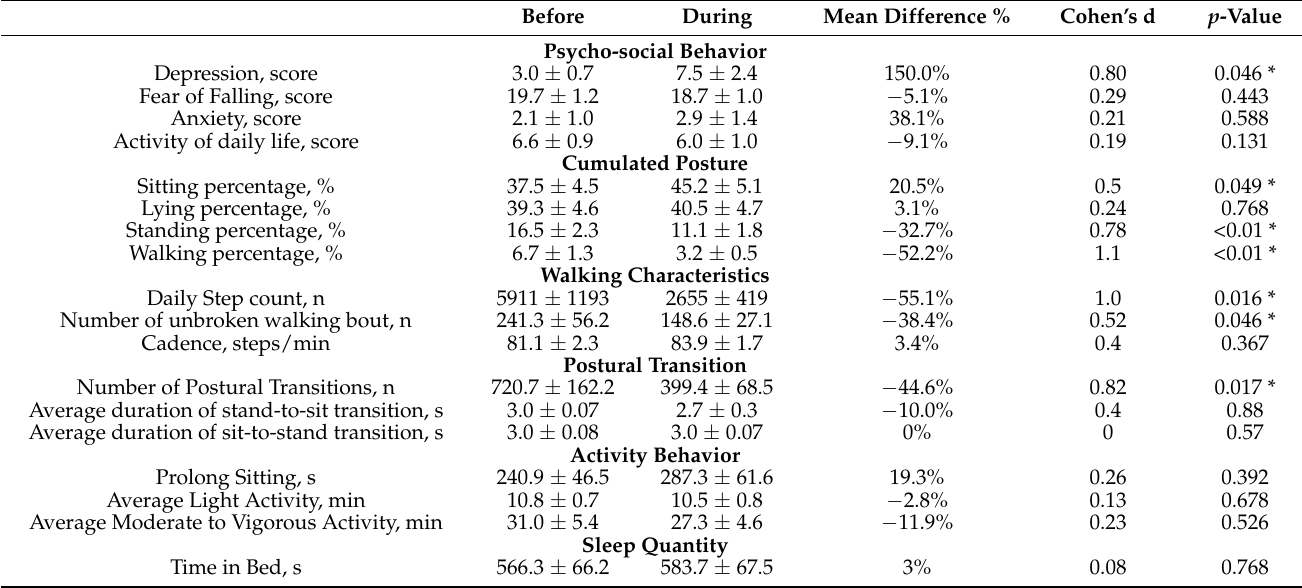
Table 2. Psycho-social, Cumulated Posture, Walking characteristics, Postural transitions, Activity behavior, and Sleep related measures assessed before and during